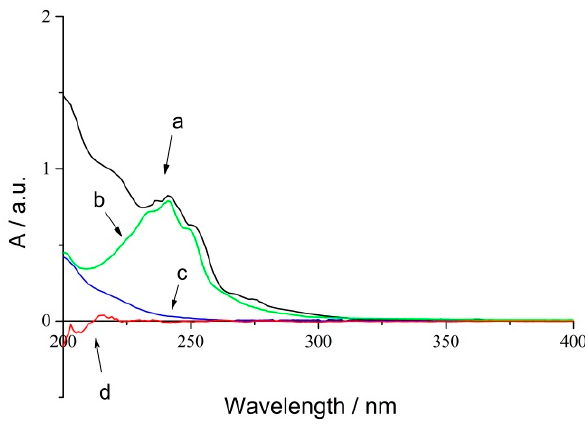
Figure 2. UV spectra of RPE photo-oxidation process ( a ) RPE; ( b ) Rosin; ( c ) Oxide of RPE; ( d ) Blank PE film.